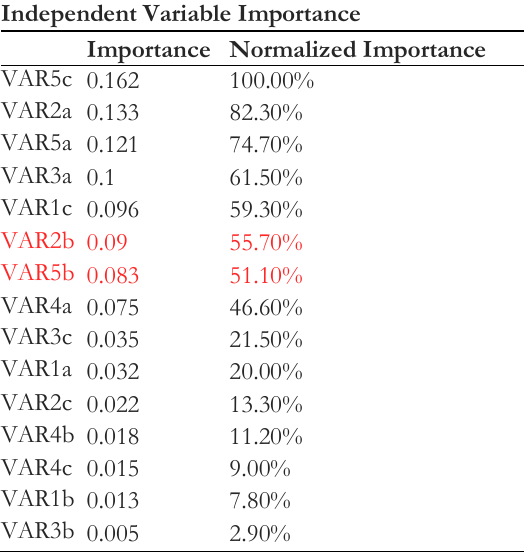
Table 12. Independent variable importance for the whole scales.